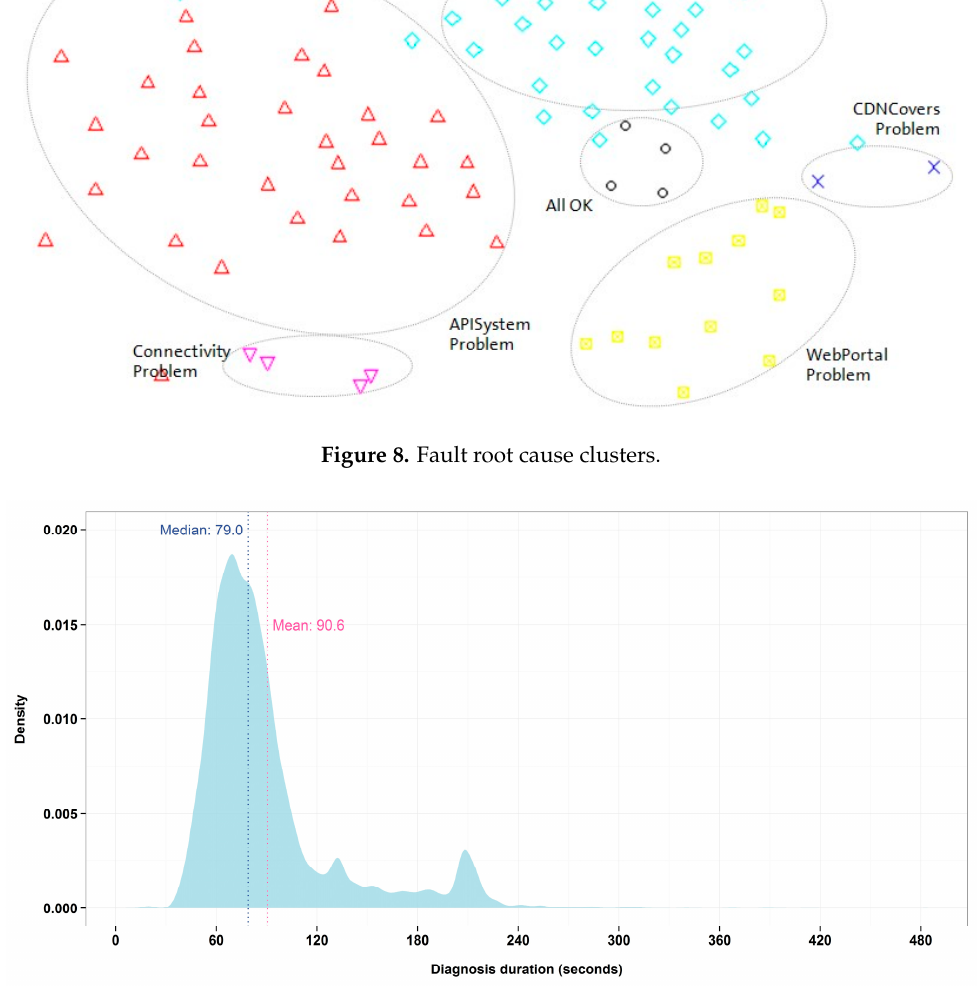
Figure 9. Density plot of diagnosis duration (in seconds).